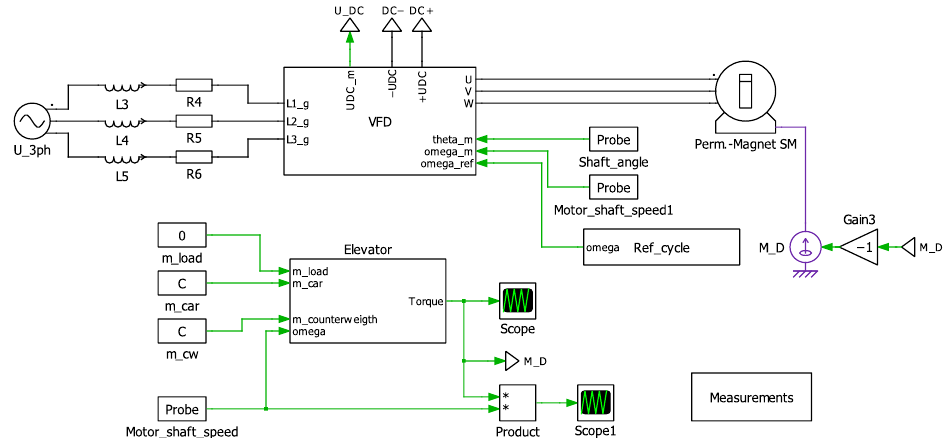
Figure 3. Elevator system simulation model in